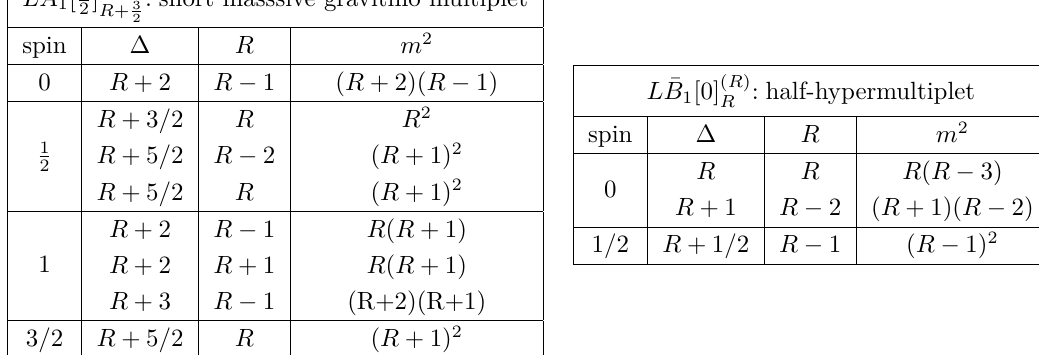
Table 3 . Shortened N = 2 multiplets.